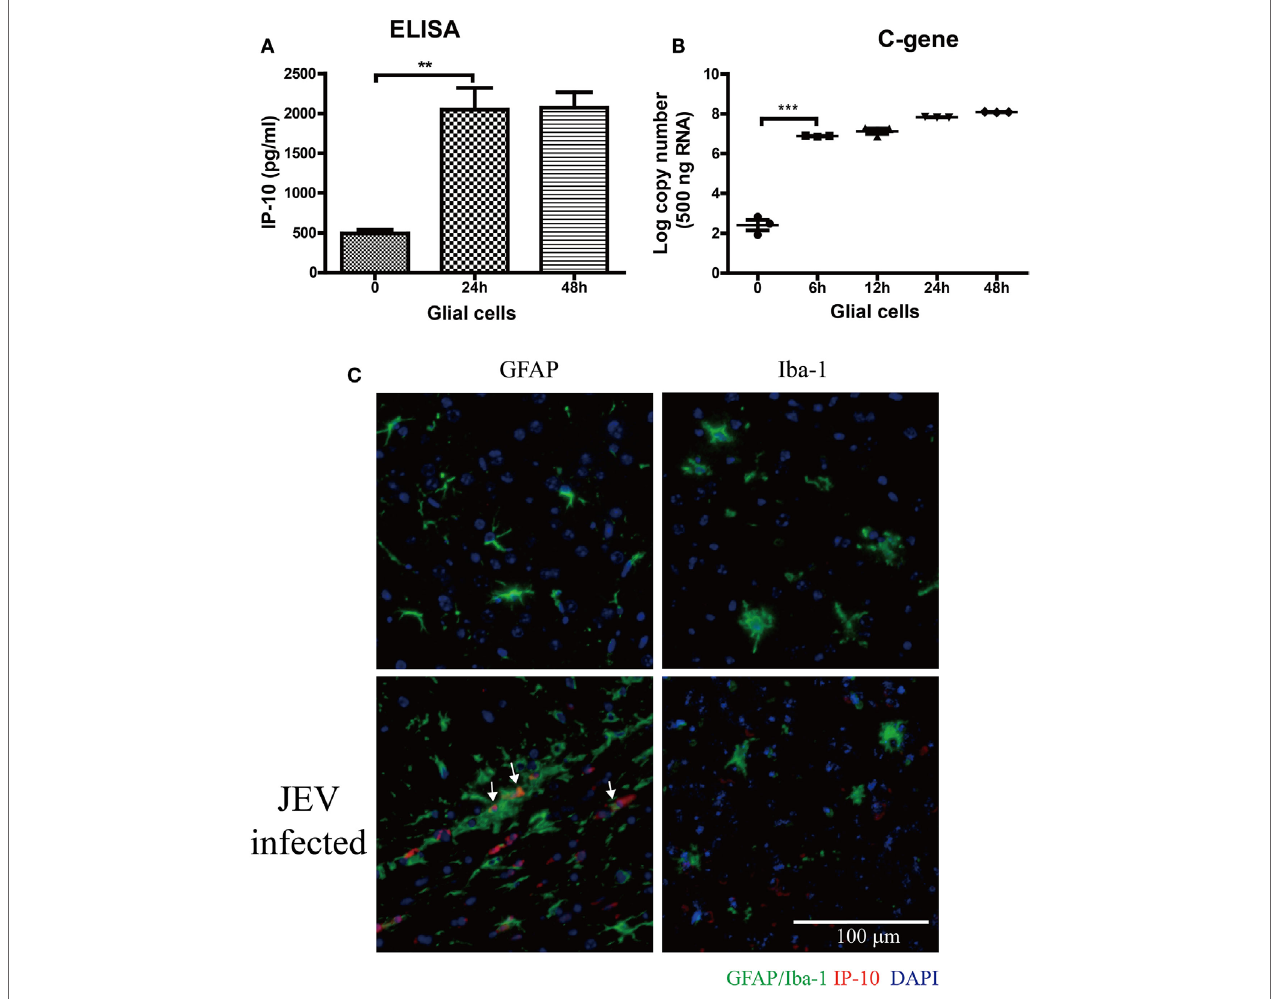
FigUre 3 | The source of IP-10 on central nervous system. Primary glial cells isolated from suckling mice were cultured in a 37°C incubator containing 5% CO 2 . Then, 5 MOI of Japanese encephalitis virus (JEV)-P3 was added to the well, and mRNA samples were collected. (a) IP-10 in the supernatant of glial cells was detected by enzyme-linked immunosorbent assay (ELISA), and (B) the copy number of the JEV-P3 C gene in primary glial cells was measured by quantitative real-time PCR. (c) Brain sections showing co-staining for GFAP/Iba-1 (green) and IP-10 (red) from mice that infected intravenously with 10 5 plaque-forming units of JEV-P3 or PBS. Nuclei are shown in blue. White arrow represents the colocalization of GAFP and IP-10. Data are shown as the mean ± SEM ( n = 3). ** p < 0.01; *** p <